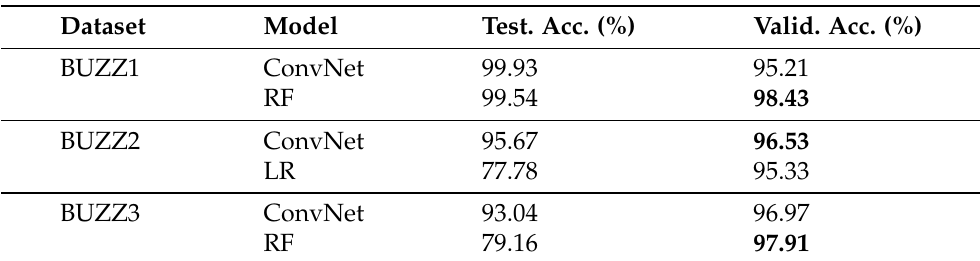
Table 5. ConvNet, RF, and LR accuracies on BUZZ1, BUZZ2, and BUZZ3; best validation accuracies are in